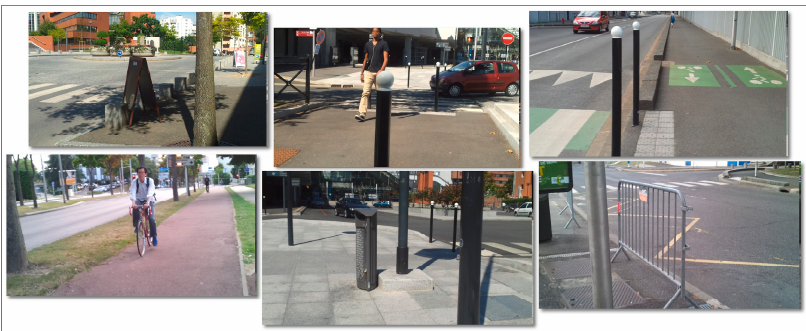
Figure 9. Examples of the videos used in the experimental evaluation.